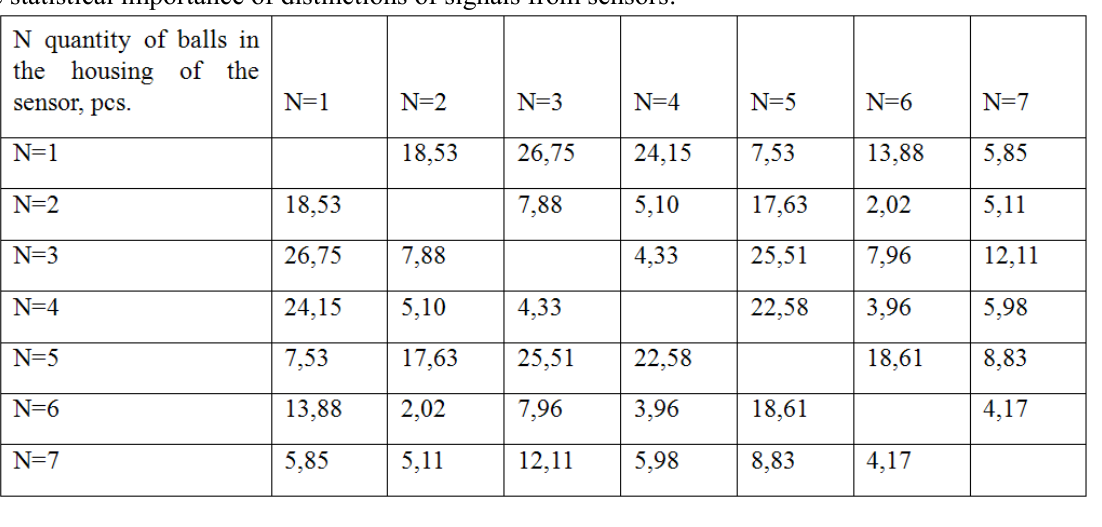
The statistical importance of distinctions of signals from